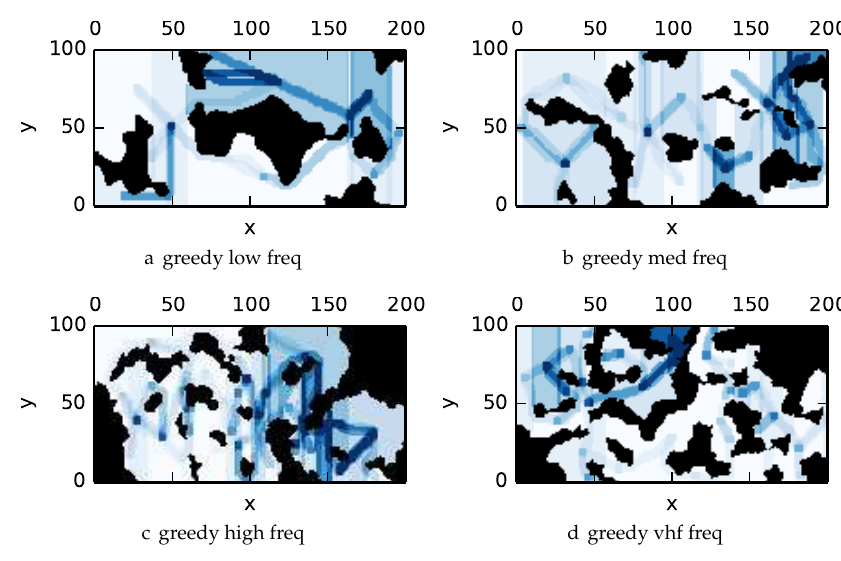
Figure 17. Multipass coverage plans in environments with nonuniform information for the greedy heuristic algorithm.